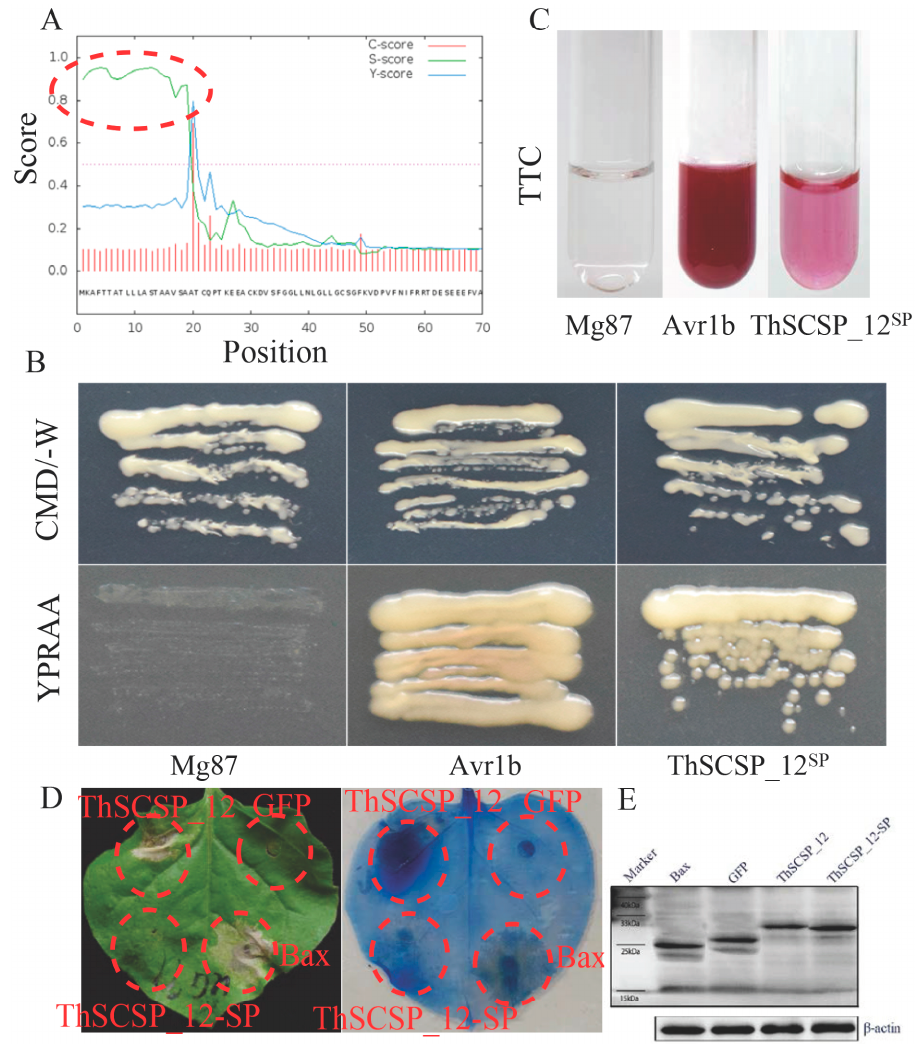
Figure 3. The signal peptide (SP) of ThSCSP_12 is functional. ( A ) The SP sequence of ThSCSP_12. ( B ) Functional validation of the SP of ThSCSP_12 using the yeast invertase secretion assay. All transformed YTK12 yeast strains were grown on YPRAA media with raffinose as the sole carbon source. N-terminal sequences of Phytophthora sojae Avr1b and Magnaporthe oryzae Mg87 were used as positive and negative controls, respectively. The untransformed YTK12 did not grow on either CMD-W or YPRAA medium. Yeast growth on CMD-W media was equally viable among the transformed strains. Mg87: negative control Mg87 SPs; Avr1bSP: positive control Avr1b SPs; ThSCSP_12 SP : SPs of ThSCSP_12. ( C ) Enzymatic activity of invertase was detected by the reduction of 2, 3, 5-triphenyltetrazolium chloride (TTC) to insoluble red-coloured 1, 3, 5-triphenylformazan (TPF). The negative control YTK12 strain carrying the ThSCSP_12’s SP did not degrade TTC to red-colored TPF. By contrast, the positive control YTK12 strain carrying Avr1b’s SP, as well as the YTK12 strain carrying Avr1b’s SP, could degrade TTC to red-colored TPF. ( D ) The predicted SP of ThSCSP_12 is required to induce cell death. ( E ) Expressed proteins were detected in the leaves of Nicotiana benthamiana following the western blot experiments. ThSCSP_12 SP denotes the SP sequence of ThSCSP_12; ThSCSP_12-SP denotes the sequence of ThSCSP_12 without the